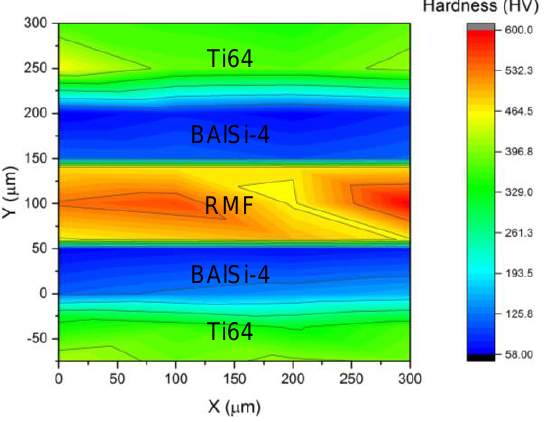
Figure 12. Hardness map of a 300 μm × 300 μm section of the brazed joint.